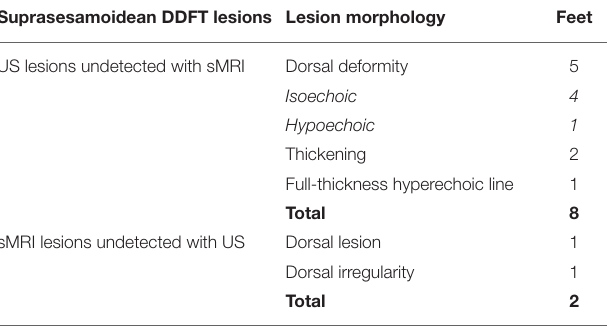
TABLE 2 | Summary of suprasesamoidean lesions detected with one modality only. Suprasesamoidean DDFT lesions Lesion